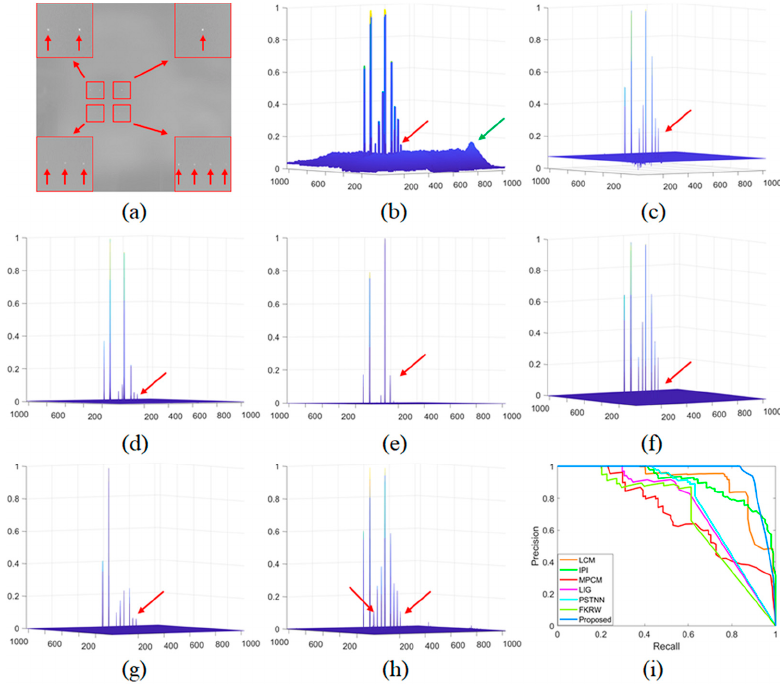
Figure 8. The performance comparison of different methods on single-pixel target detection: ( a ) tar- get image; ( b ~ h ) normalized 3-D mesh obtained by the LCM [18], IPI [10], MCPM [19], LIG [22], PSTNN [12], FKRW [15], and the proposed method; and ( i ) PRC comparison. The red arrows indicate the targets, and the green arrows indicate the noisy clutters.